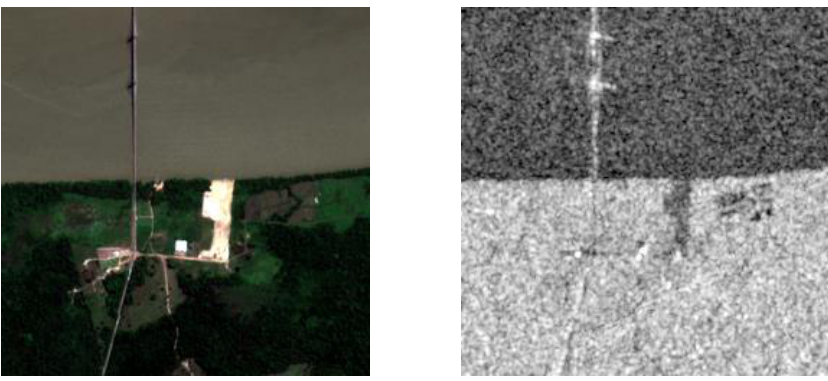
Figure 1. A comparison between SAR ( right ) and optical ( left )